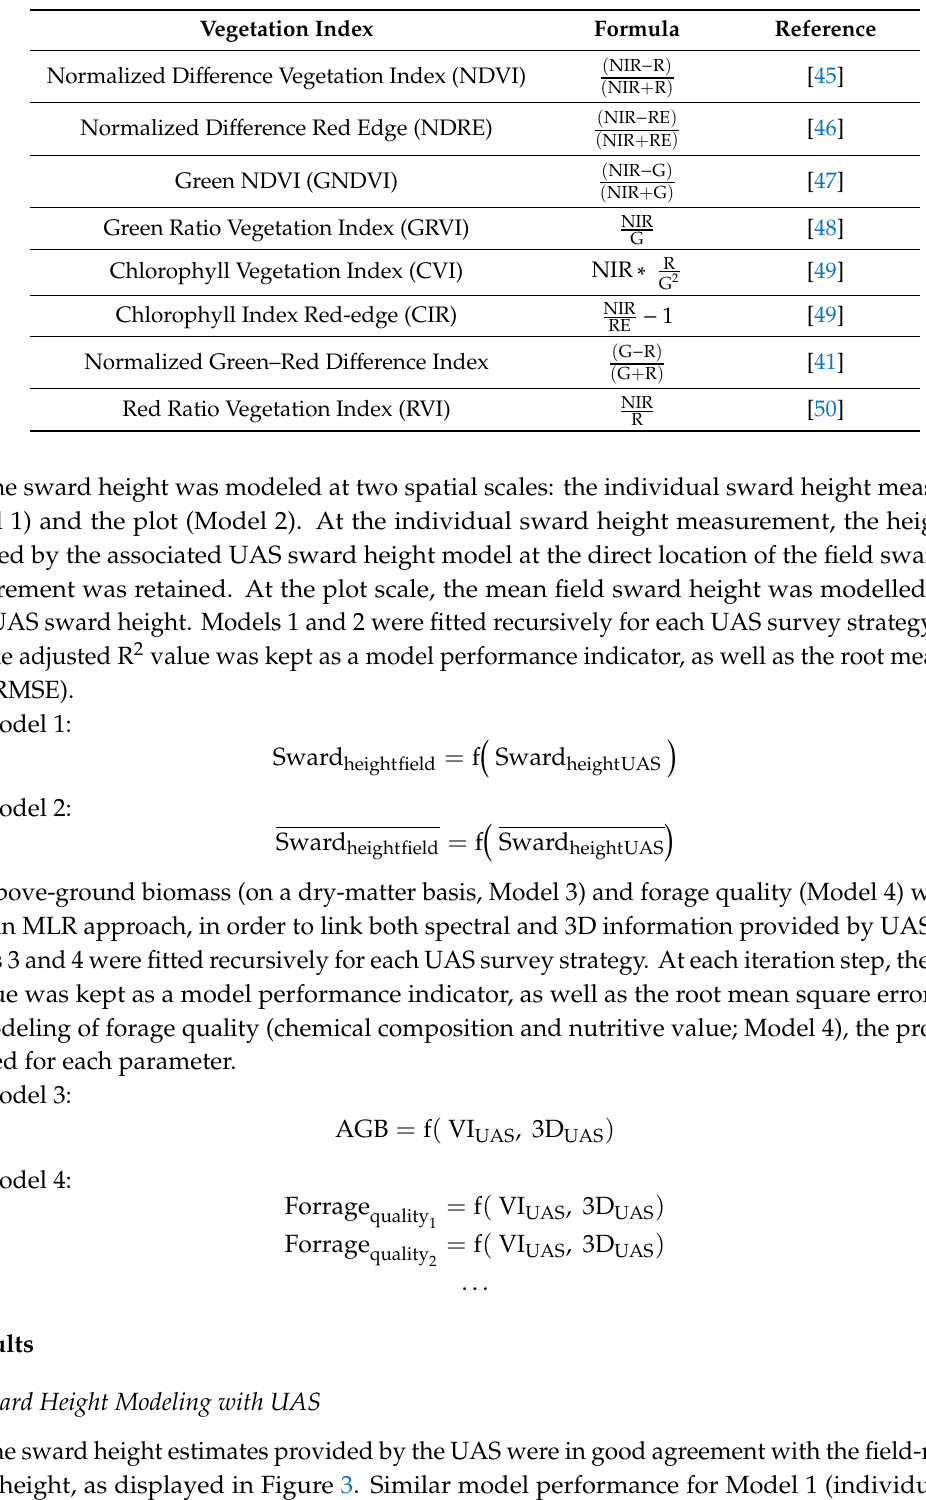
Table 3. Vegetation indices computed from the reflectance layers provided by the multispectral camera. R: red; G: green; NIR: near-infrared; RE: